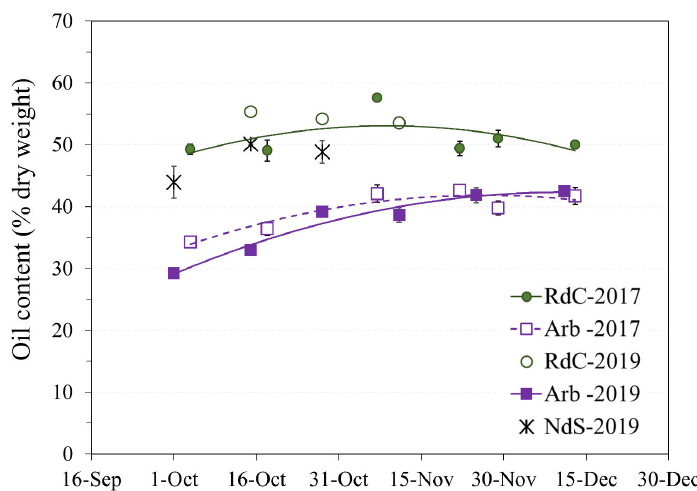
Figure 3. Evolution of oil content on a dry basis in the “Arbequina” (Arb; square; violet), “Royal de Calatayud” (RdC; circle; green), and “Negral de Sabiñán” (NdS; cross; black) olive oils according to harvest date in 2017 (continuous line) and 2019 (dotted line) crop years.